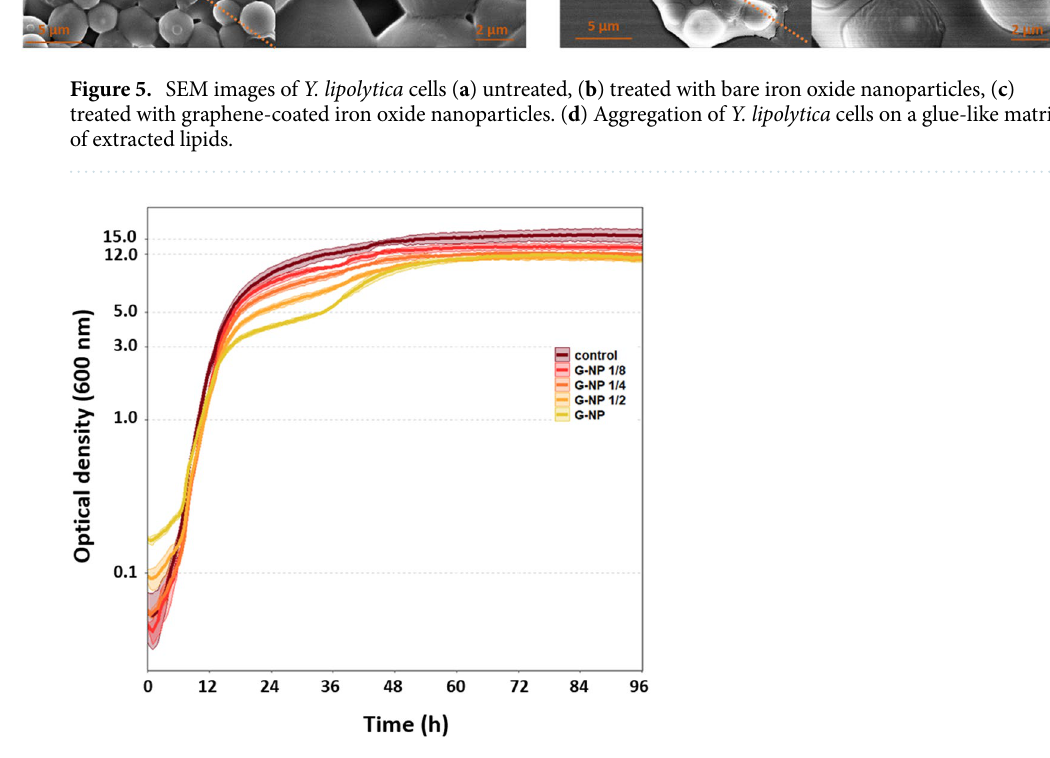
Figure 6. Growth of Y. lipolytica with and without presence of graphene- coated nanoparticles. Cells were incubated at 30 °C and 200 rpm and growth was monitored for 96 h at the interval of 30 min. Each curve and its respective shadow represent the mean values and standard deviation of biological triplicate experiments. G-NP denotes the standard working concentration of graphene-coated nanoparticles. G-NP 1/2, G-NP 1/4 and G-NP 1/8 are respective dilutions of the standard working concentration